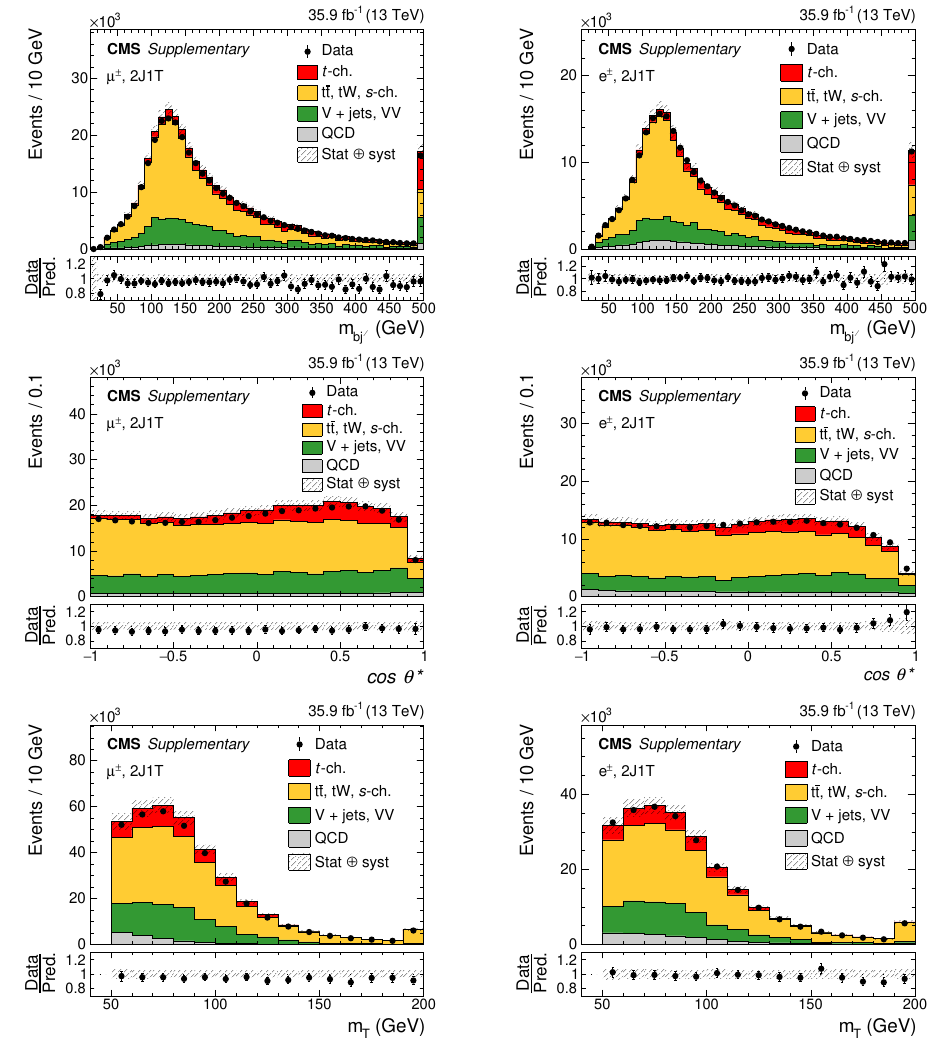
(upper row), cos θ ∗ (middle row), and m (lower row) for the Figure 11 . Distributions of m T bj 0 muon (left) and electron (right) final states in the 2J1T category for data (points) and simulation (colored histograms). The lower panel in each plot shows the ratio of the data to the predictions. The bands indicate the statistical and systematic uncertainties added in quadrature. The last bin in each of the upper- and lower-row plots includes the